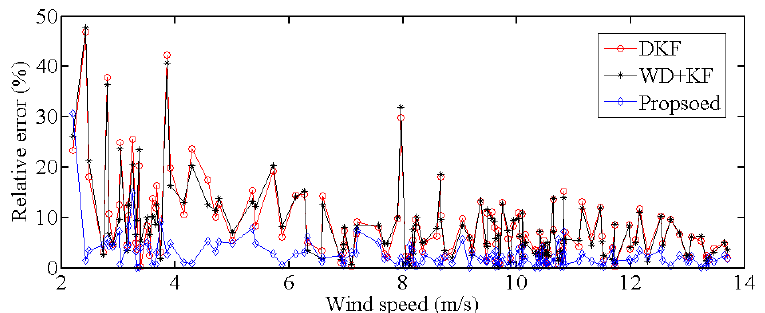
Figure 16. Prediction errors via wind speed.